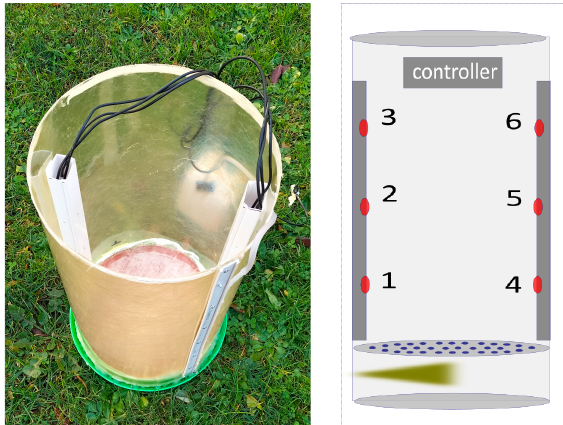
Figure 7. Steady-state chamber. Points 1–6 refer to the placement of the sensor.